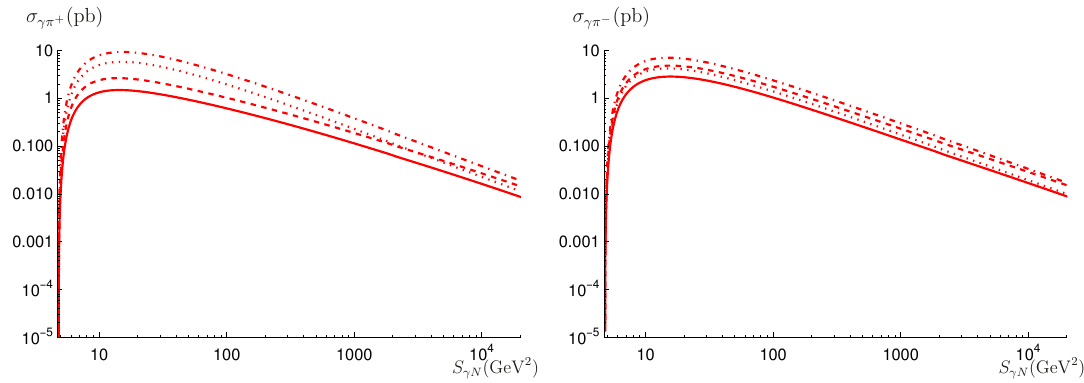
Figure 26 . The single differential cross-section for π + ( π − ) is shown as a function of M 2 left (right) for different values of S 800 , 4000 , 20000 GeV 2 . The dashed (non-dashed) lines correspond to holographic (asymptotic) DA, while the dotted (non-dotted) lines correspond to the standard (valence) scenario. The holographic DA with the standard scenario has the largest contribution for every S log scales.